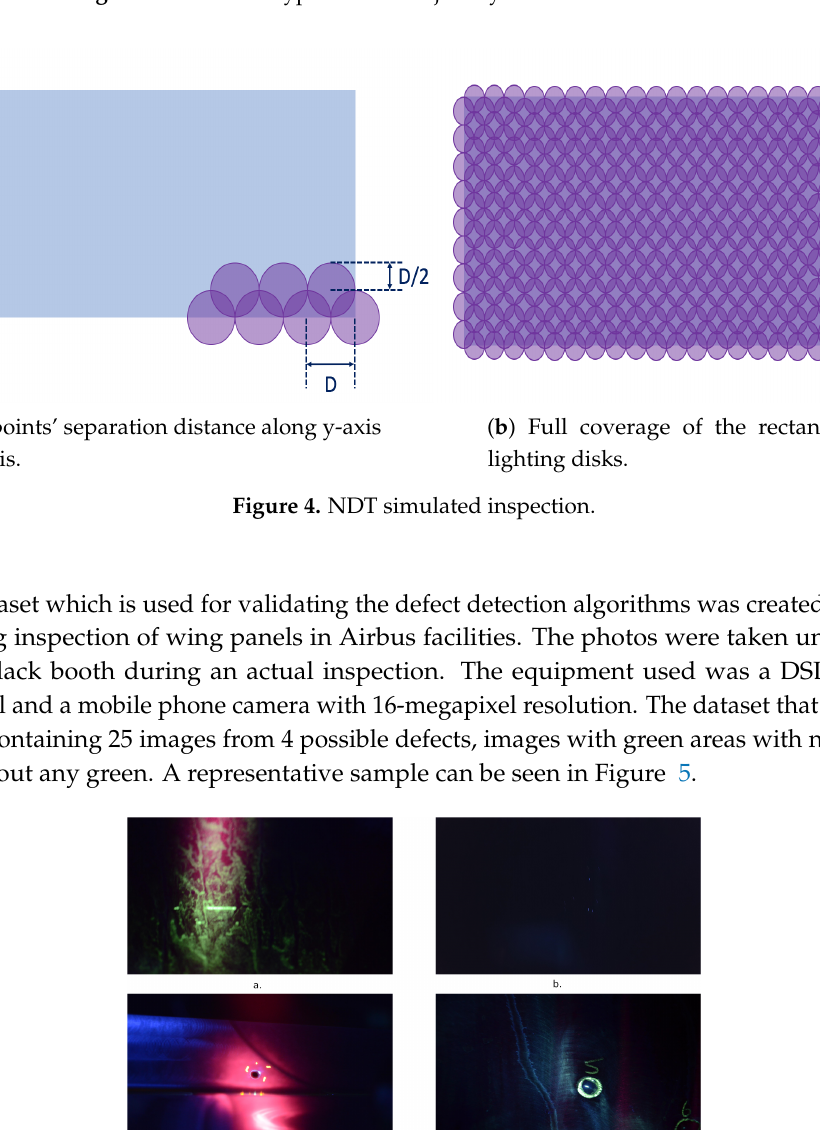
Figure 3. Desired waypoints and trajectory used for the simulations.